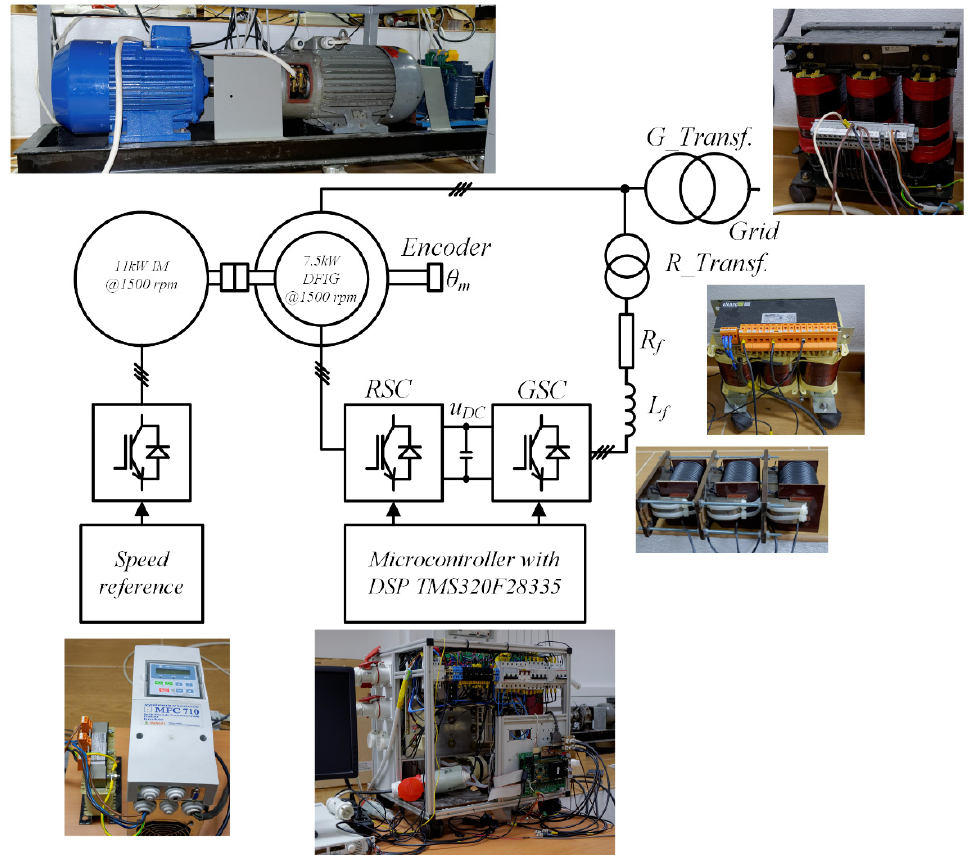
Figure 15. DFIG based laboratory set-up.